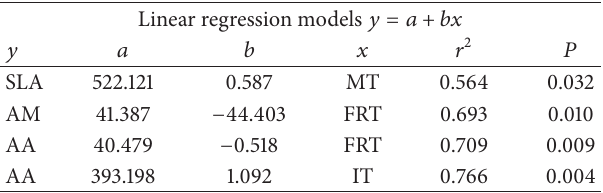
Table 3: Significant linear regressions between physical and flammability parameters. Linear regression models 𝑦 = 𝑎 + 𝑏𝑥